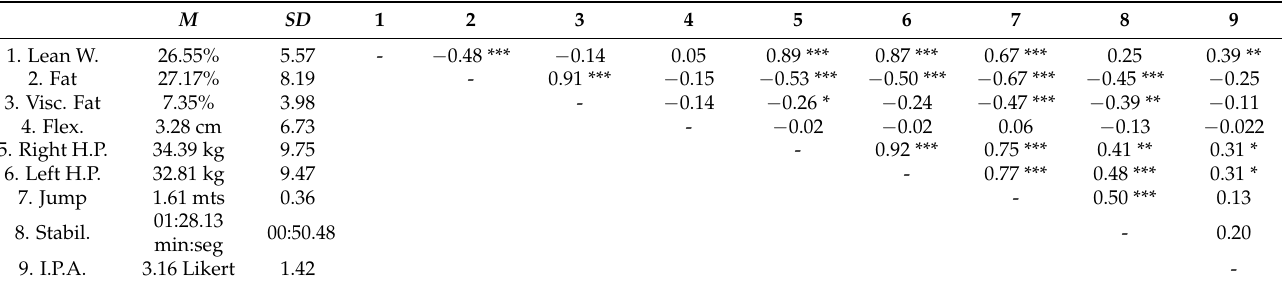
Table 2. Descriptive Statistics and Correlations Between Variables